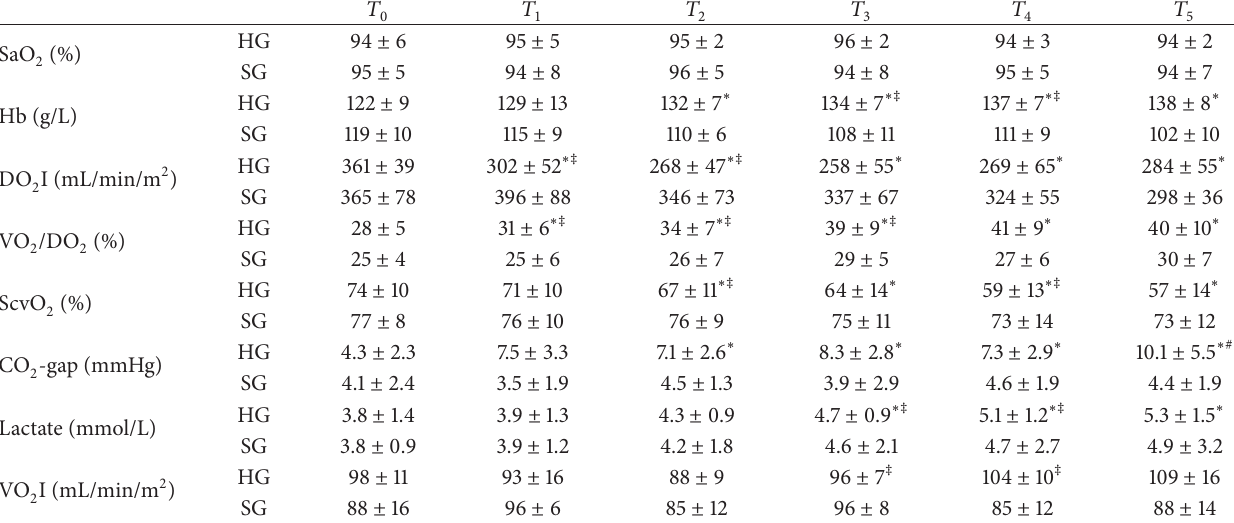
Table 2: Changes of oxygen balance.